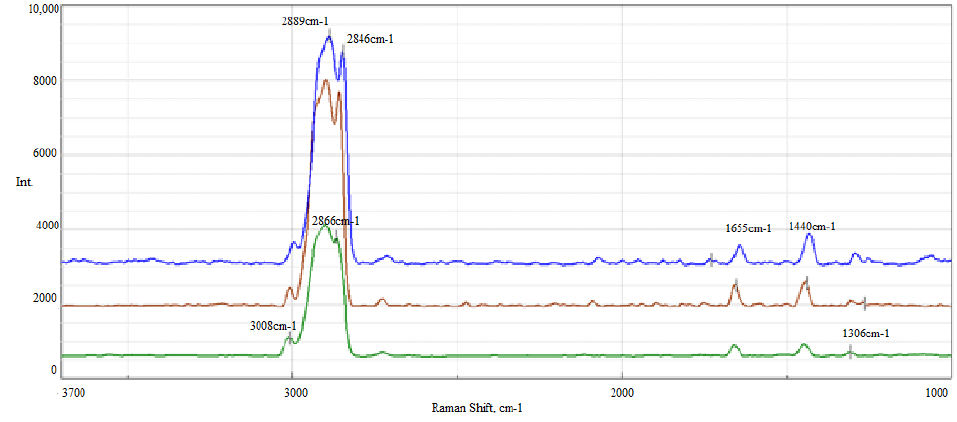
Figure 2. Raman spectra of A oil—green line, A_120 oil, oxidised at 120 °C—brown line and A_G oz oil after anti-wear test—blue line, in the 3700–1000 cm − 1 range.